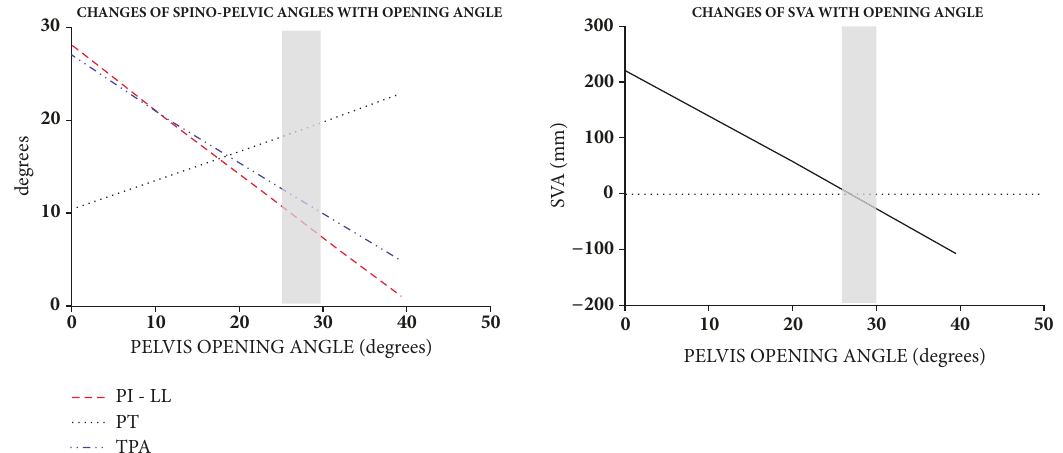
Figure 6: Graphs showing the relationship of osteotomy opening angle (OA) with spinopelvic parameters and SVA. The grey area represents the range of opening angles where optimal sagittal deformity correction is achieved.